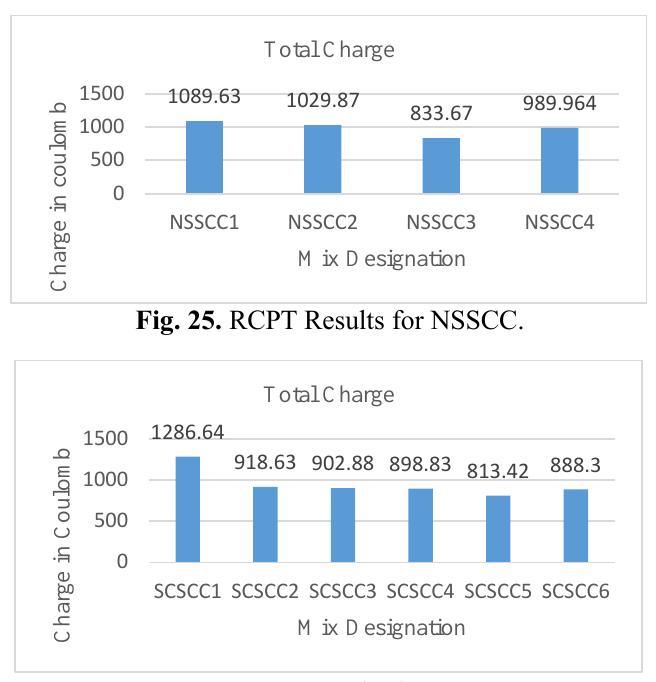
Fig. 26. RCPT Results for SCSCC.